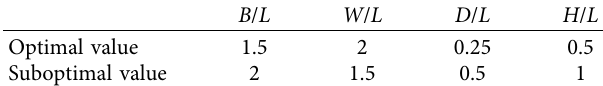
Table 9: Optimal and suboptimal value of the control parameters.